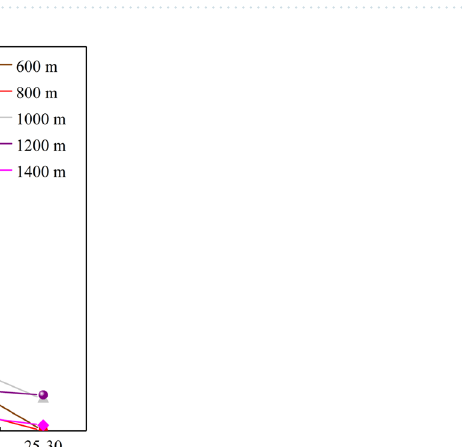
Figure 4. The characteristics of coal and gas outburst [( a ). splitting phenomenon of outburst hole ( b ). Sketch of different areas of outburst coal powder].